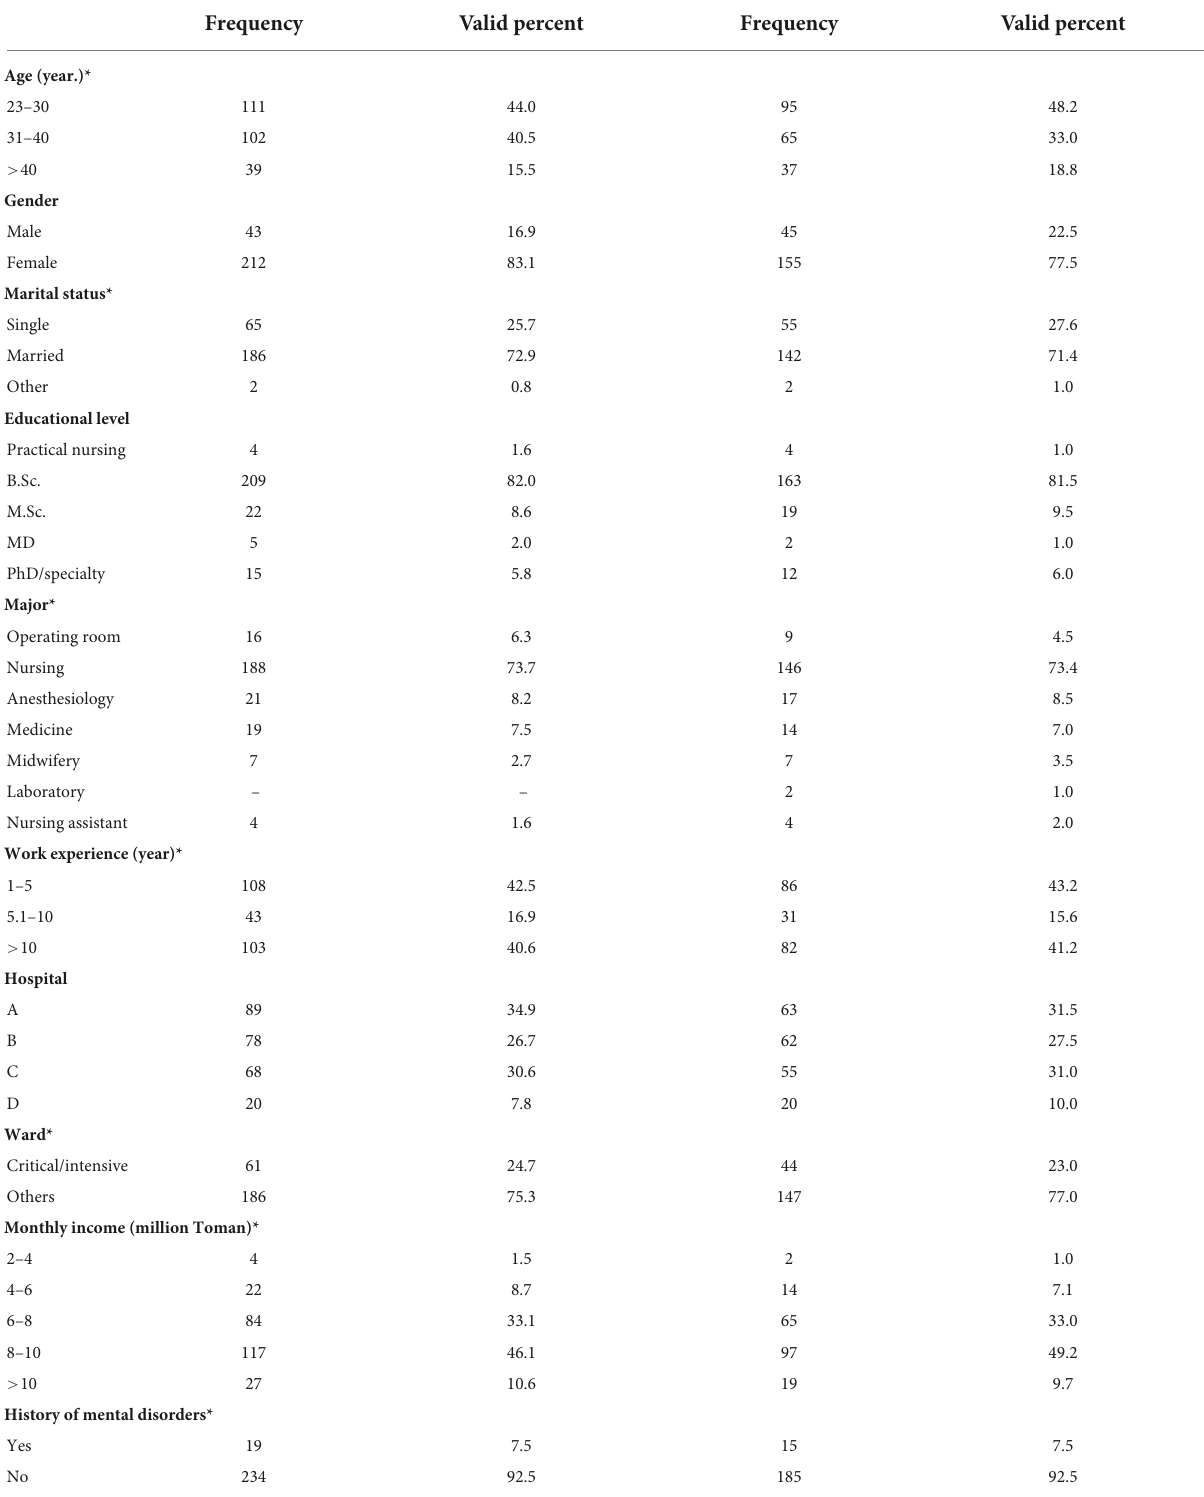
TABLE 2 The participants’